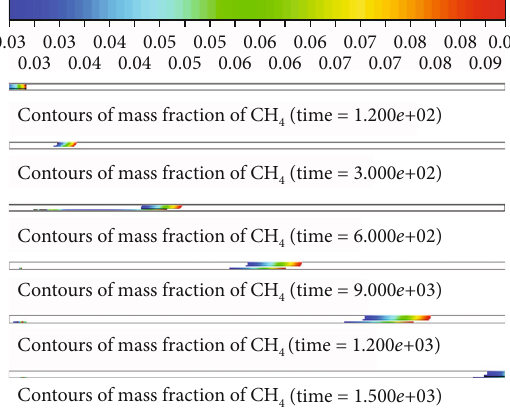
(time = 1.200 e+ 4 (time = 3.000 e+ 02) 4 (time = 6.000 e+ 02) 4 (time = 9.000 e+ 03) 4 (time = 1.200 e+ 03) 4 (time = 1.500 e+ 03) 4 explosion cloud of tunnel central 4